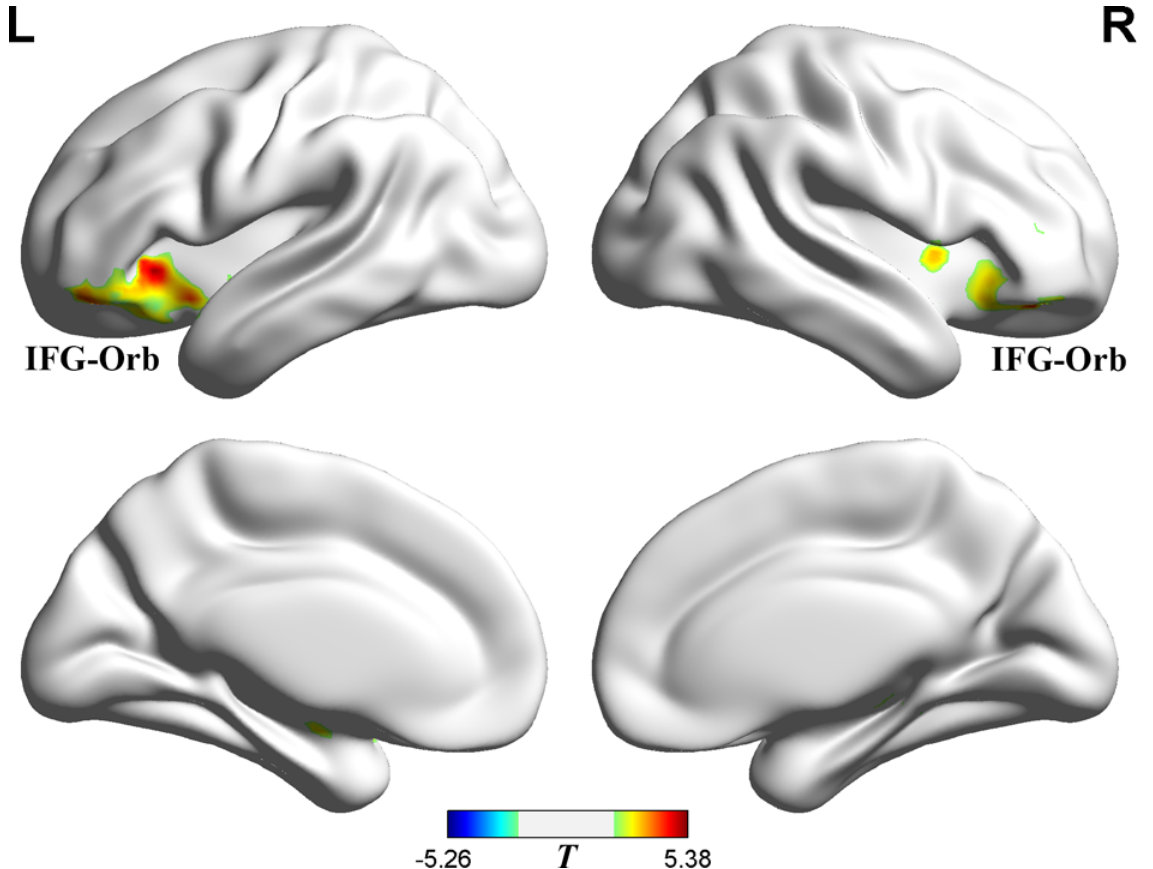
Fig 5. Distractor-switching condition > no-switching condition. Posed on medium view. Threshold: p = 0.05 (AlphaSim corrected). The red shows the regions that are more active in the distractor-switching condition.